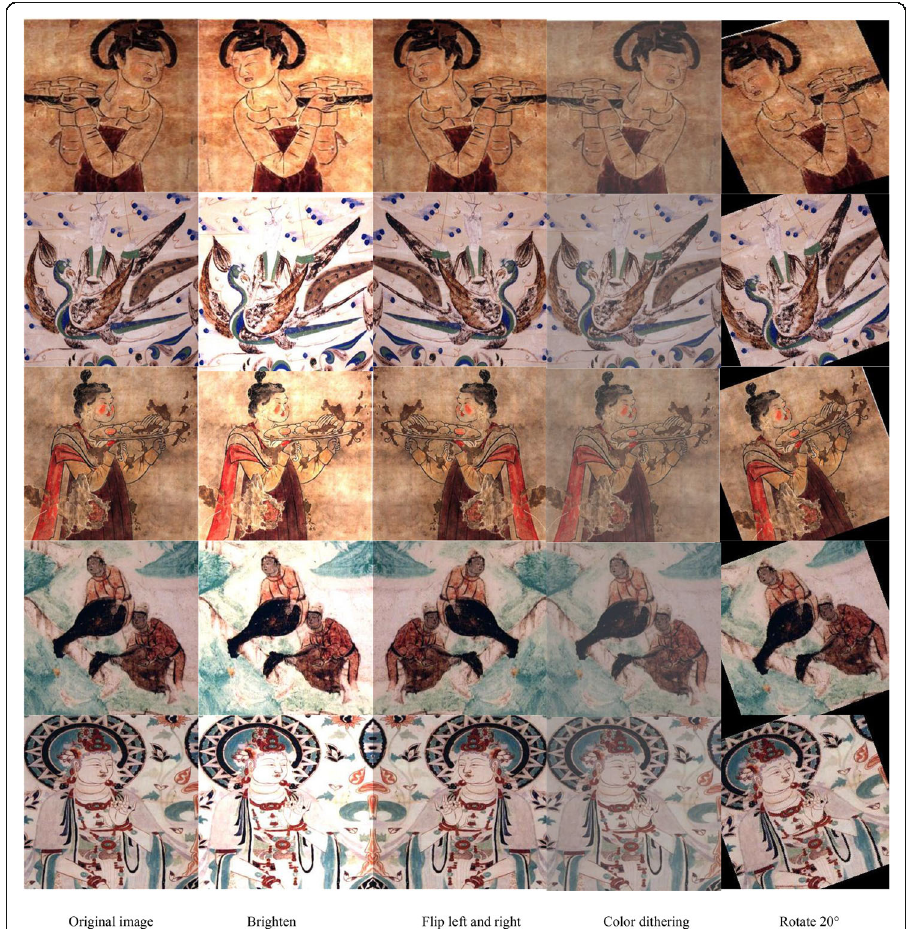
Fig. 5 Example images after data